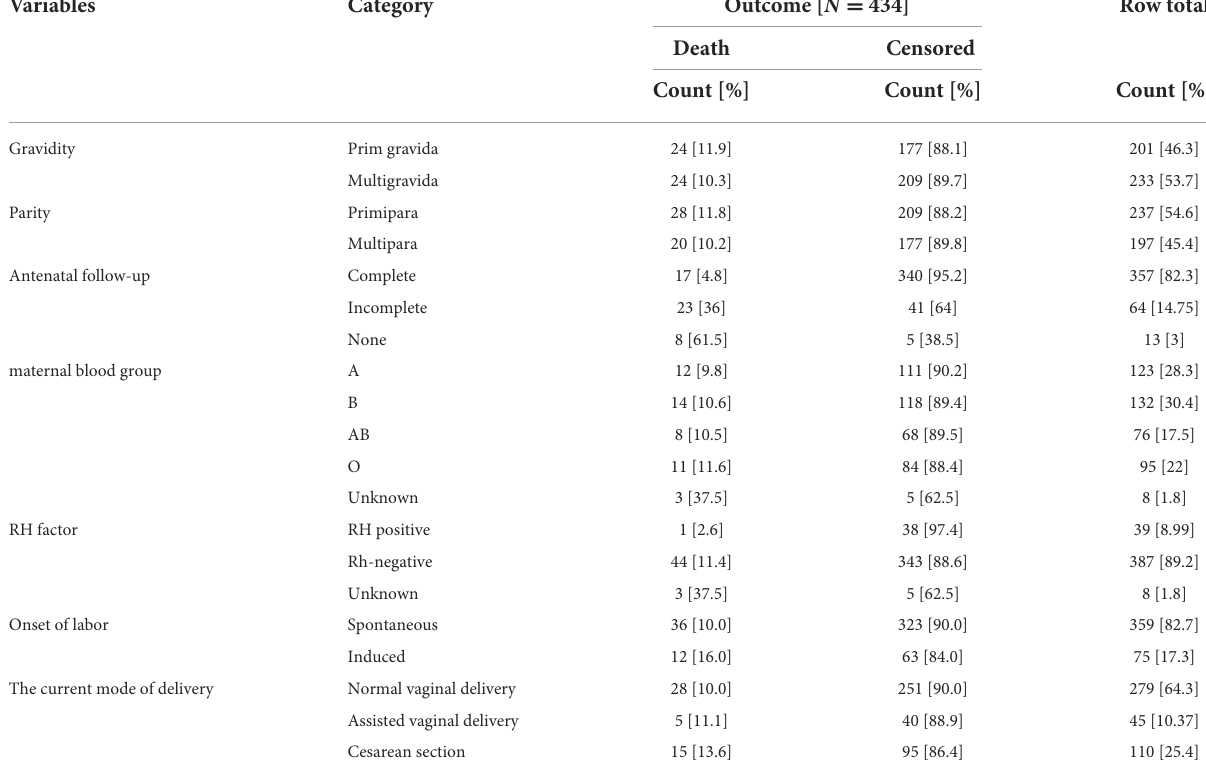
TABLE 2 Maternal health conditions in NICU, TASH, Addis Ababa, Ethiopia, from 1 January 2015 – 30 December